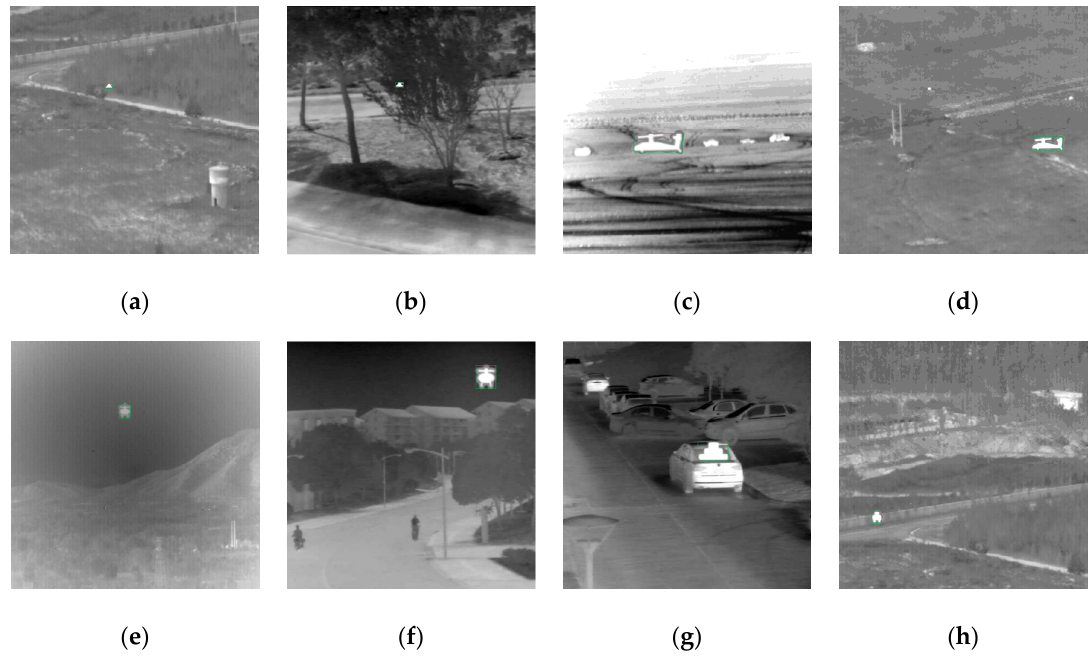
Figure 5. Some of the infrared target recognition dataset, including changes of target type, aspect orientation (front and side), size, contrast, and scene (road ( a ), ( h ), tree ( b ), desert ( c ), grassland ( d ), mountain ( e ), building ( f ), and car ( g )).